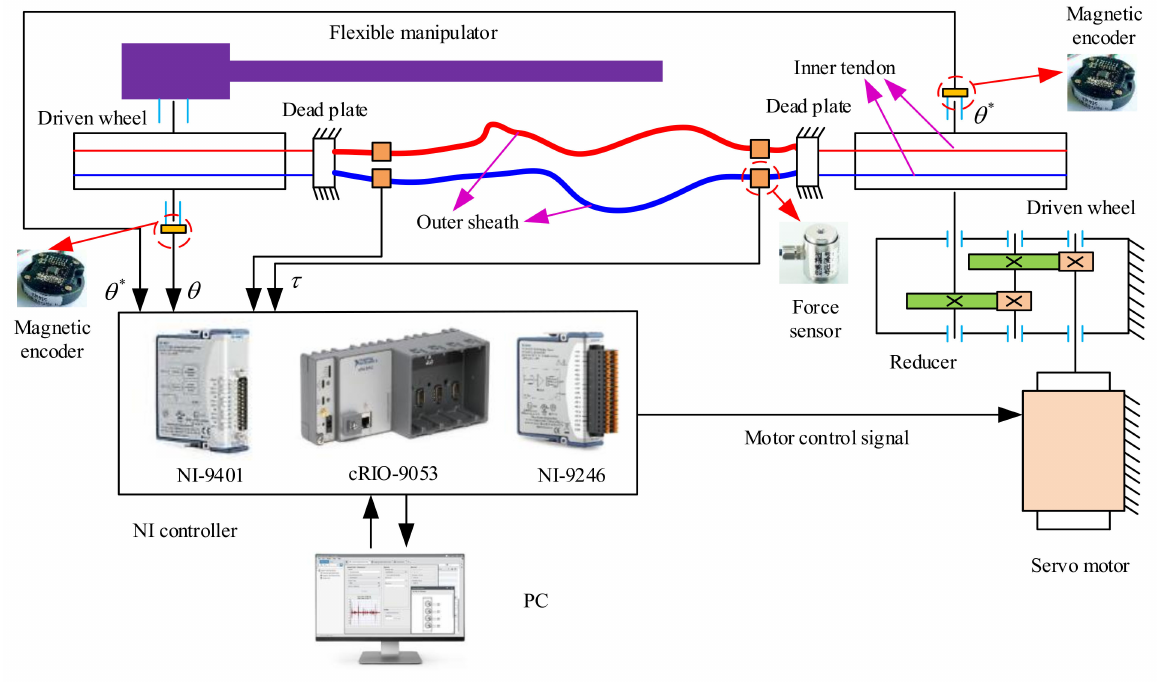
Figure 15. The control principle of the experimental